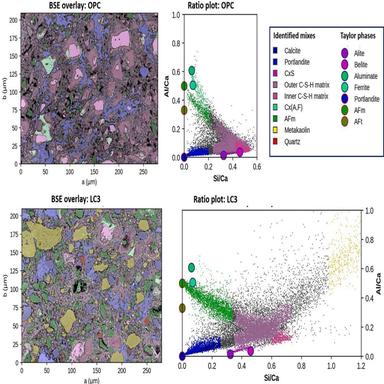
Illustration of phase separation for samples of OPC and LC3 cured at 28 days of hydration. The left-hand side figure shows the phase masks overlay for their respective BSE micrographs, and the right-hand image shows the Al/Ca vs. Si/Ca ratio plots. Image reproduced and adapted from.